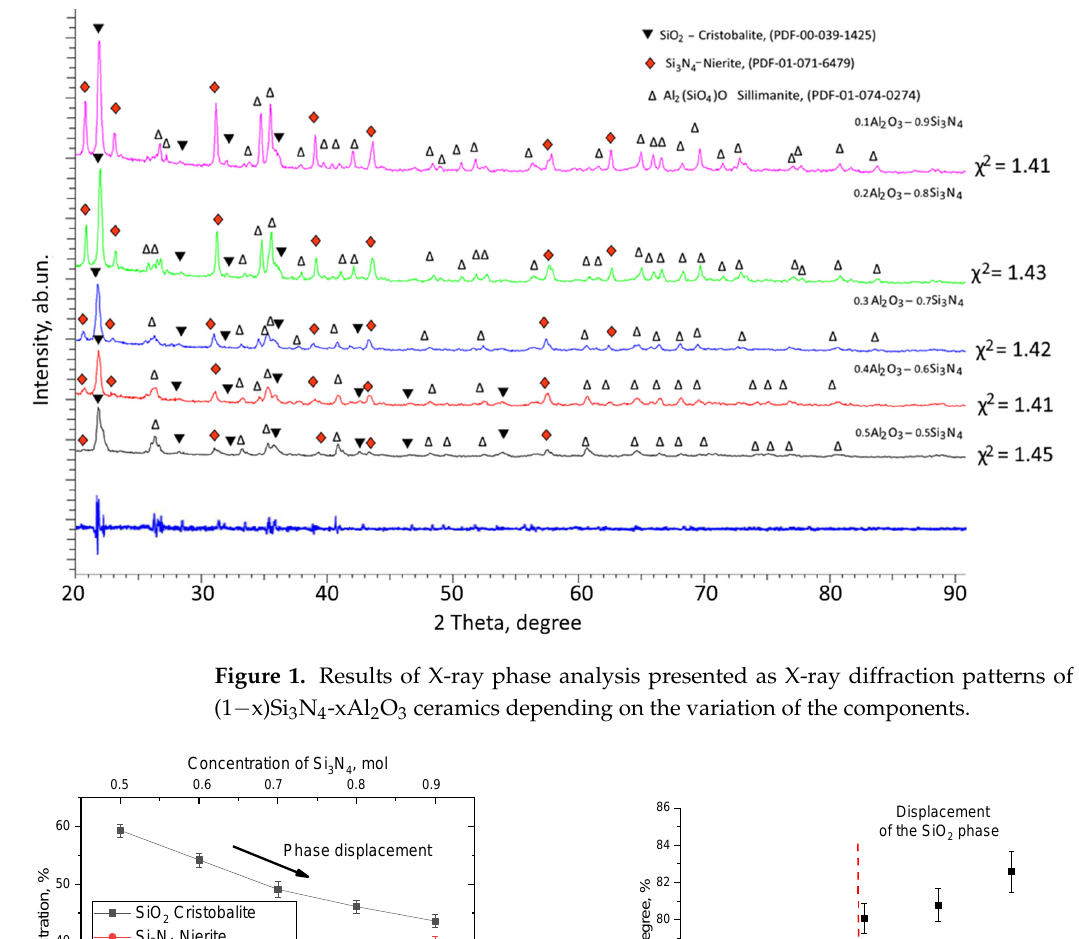
Figure 1. Results of X-ray phase analysis presented as X-ray diffraction patterns of the studied (1 − x)Si 3 N 4 -xAl 2 O 3 ceramics depending on the variation of the components.